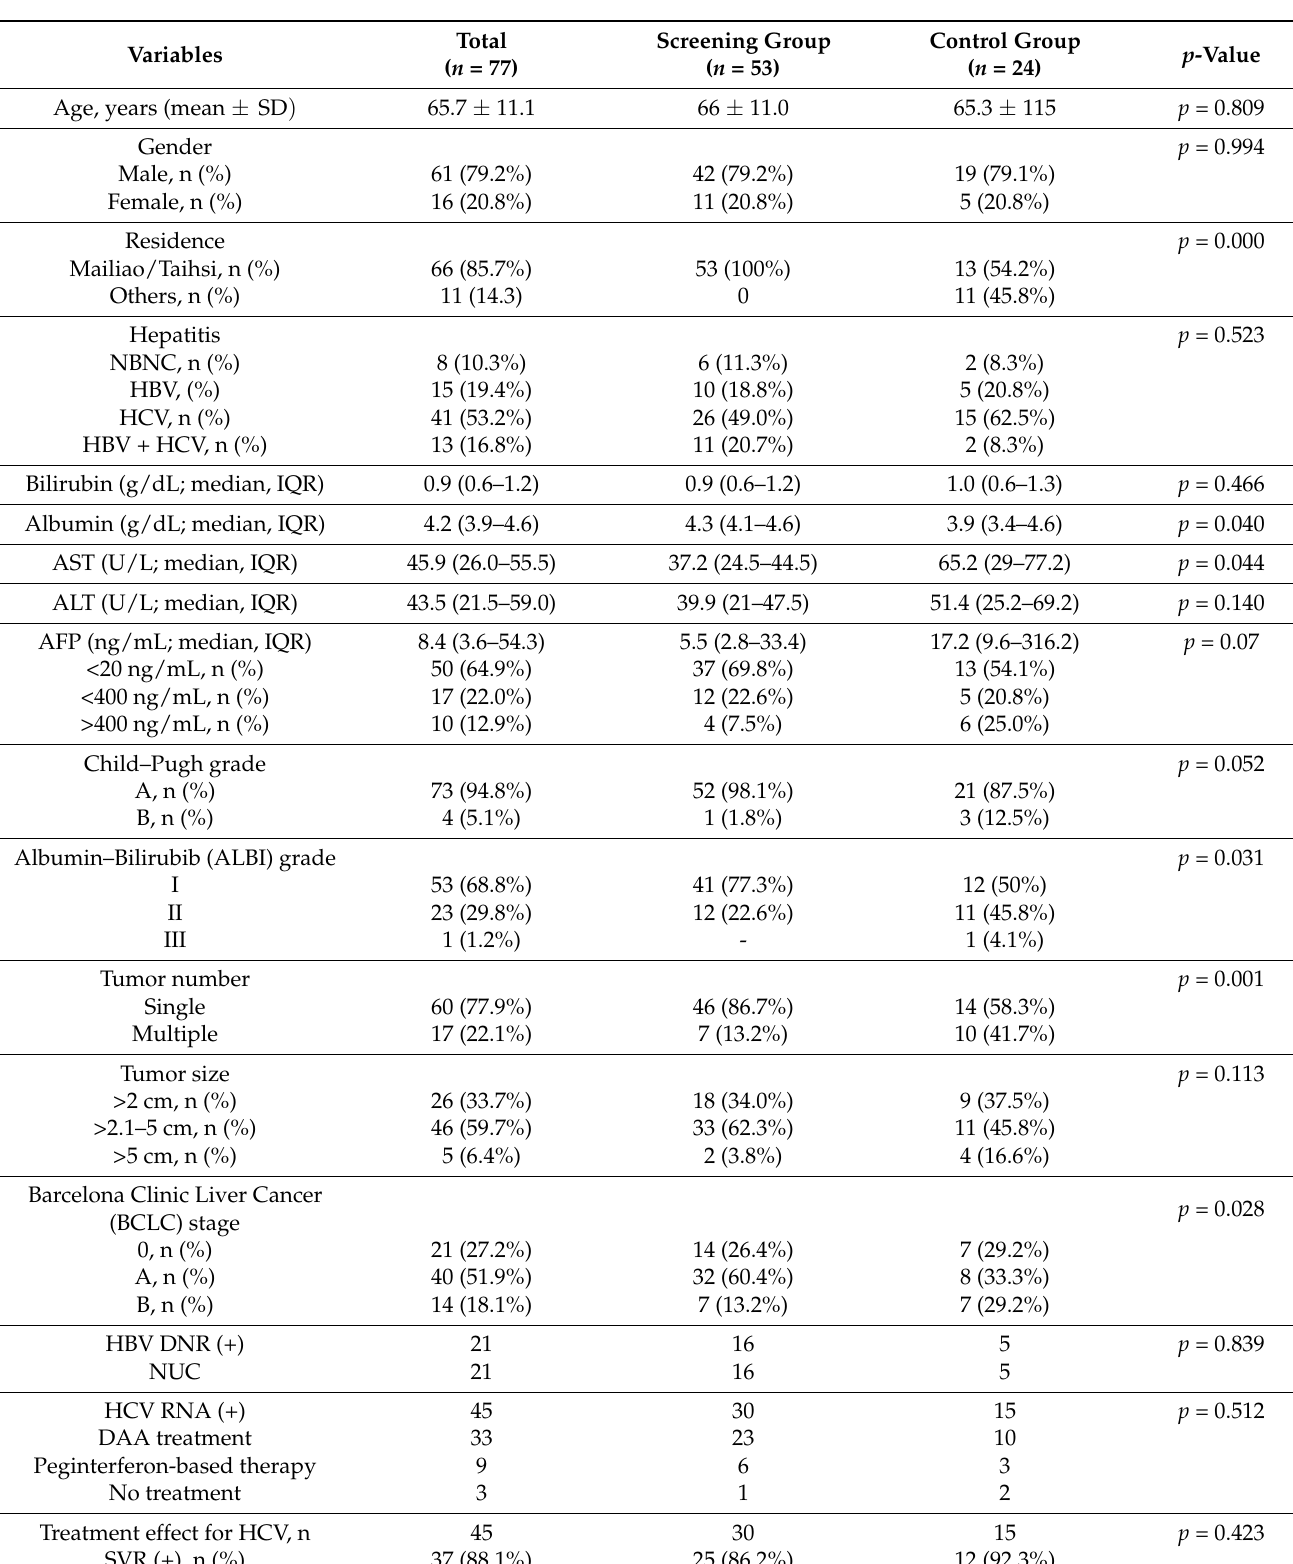
Table 1. Clinical, laboratory and radiological features of the 77 HCC patients in the screening and control